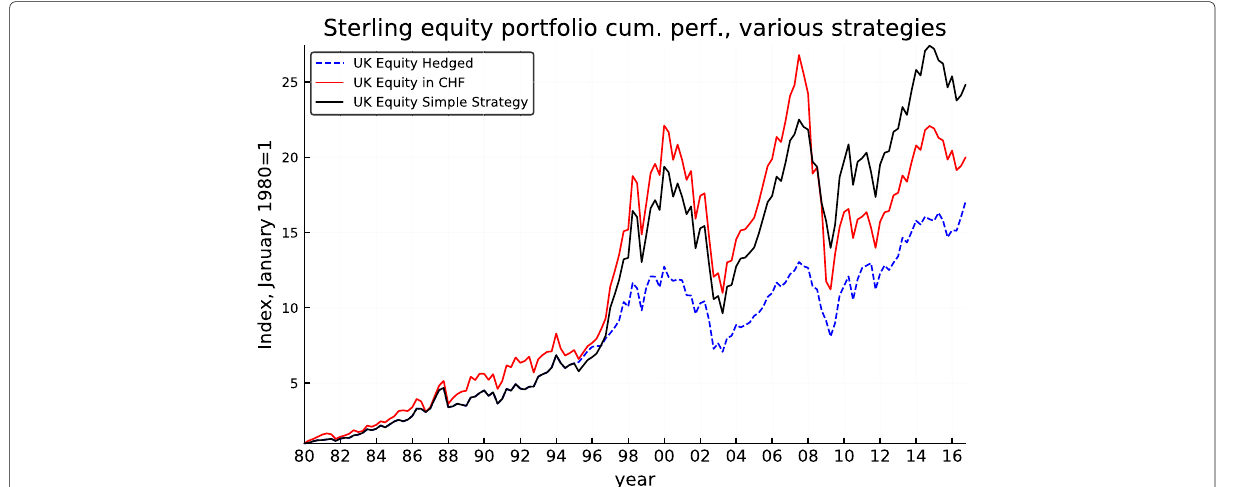
Fig. 10 Sterling equity cumulative performance: unhedged, hedged, and simple